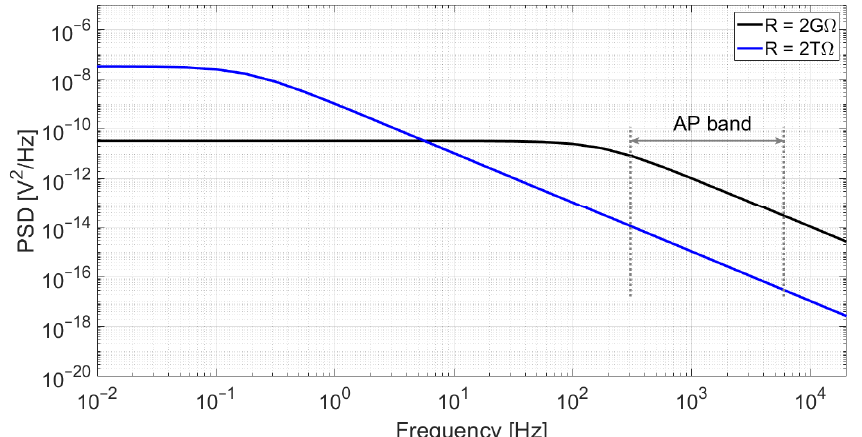
Figure 3. Simulation of the output noise of an RC low-pass filter for C = 350 fF and two different resistor values: R = 2 G Ω ( black ) and R = 2 T Ω ( blue ). Although a higher resistance value yields higher power spectral density at low frequencies, the cut-off frequency is significantly reduced, which results in lower noise at high frequencies. In this example, the integrated noise in the action-potential band (300 Hz–6 kHz) is 58 μ Vrms for R = 2 G Ω and only 2.0 μ Vrms for R = 2 T Ω .